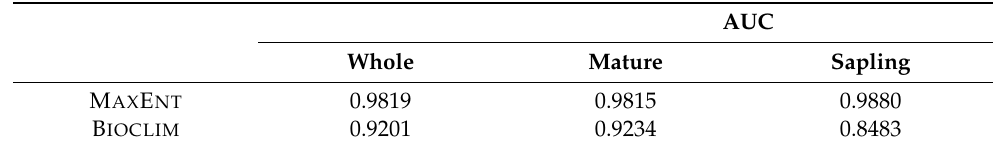
Table 1. Average evaluation (10 iterations) of the distribution models for the different life stages: whole, mature, and sapling.